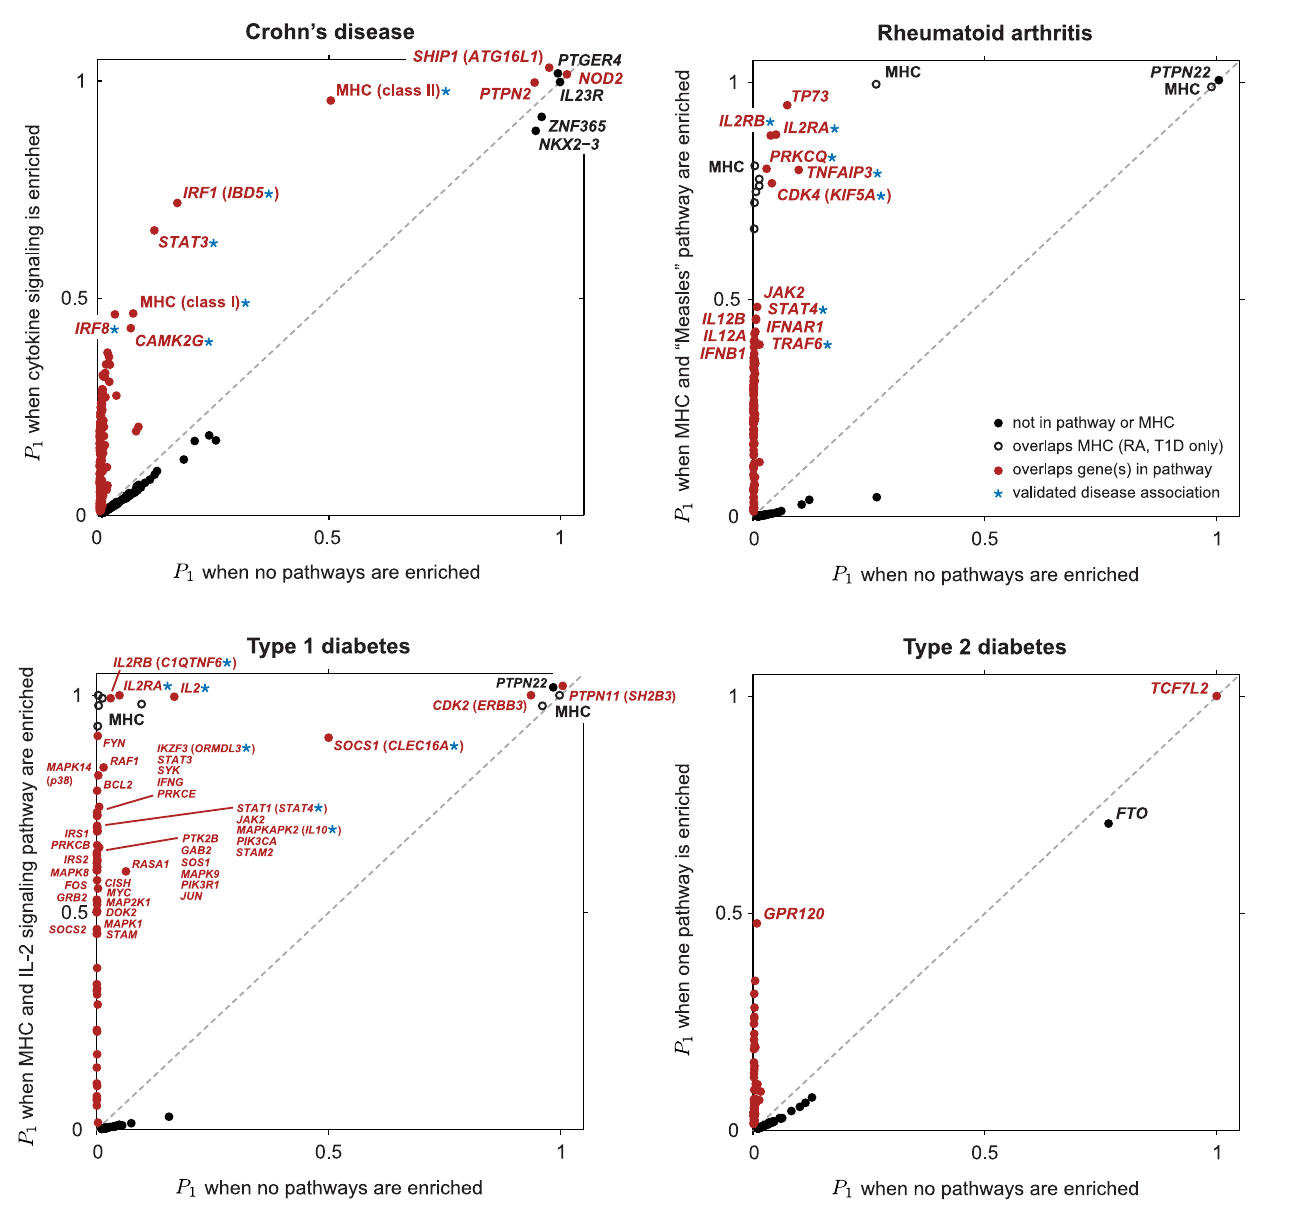
assigned to the enriched pathway (for T2D, at least 1 out of 5 top pathways). In RA and T1D, 50-SNP segments overlapping the MHC are drawn as open circles (SNPs in these segments are not assigned to the pathway). Overlapping segments sharing the same association signal are not shown. Some segments are labeled by gene(s) in pathway and/or most credible gene of interest based on prior studies (most credible gene is shown in parentheses if different from pathway gene). Asterisk (*) indicates an appreciable increase in the probability of a disease association, and